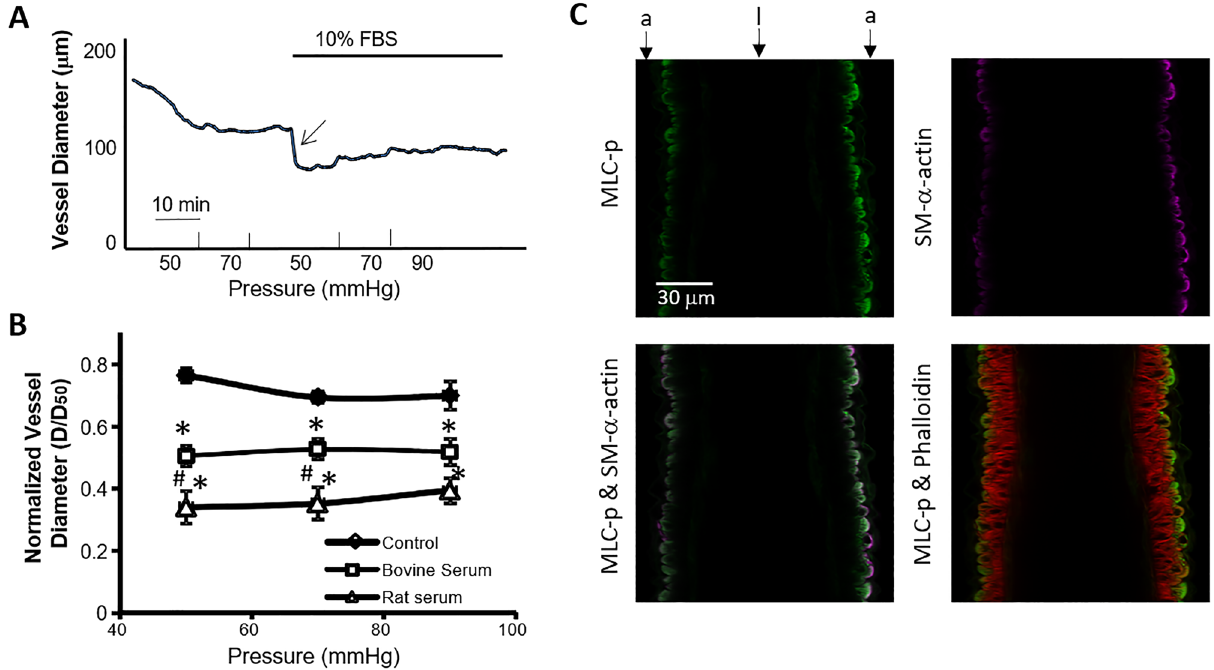
Figure 3. Serum (10%) induced vasoconstriction of SCA. ( A ) A typical recording of SCA diameter at indicated intraluminal pressures before (control) and after exposure to 10% serum. Arrow depicts the robust vessel constriction after serum treatment. Bar shows time scale. ( B ) Effect of exposure to 10% serum on SCA myogenic tone. D: vessel diameter 10 min after pressure elevation; D 50 : passive vessel diameter at 50 mmHg. * p < 0.05 compared to control. Control: n = 6; bovine serum: n = 4; rat serum: n = 6. # p < 0.05 compared to Bovine serum. ( C ) Representative longitudinal sectional view of SCA maintaining a steady state vasoconstriction after exposure to 10% rat serum. The gradient distribution of MLC-p (green) and SM-α-actin (purple) in the vessel wall is evident in the wall of serum treated SCA, as compared to the phalloidin staining (red). a: depicts adventitia side of vessel wall; l: depicts intra-luminal side of vessel